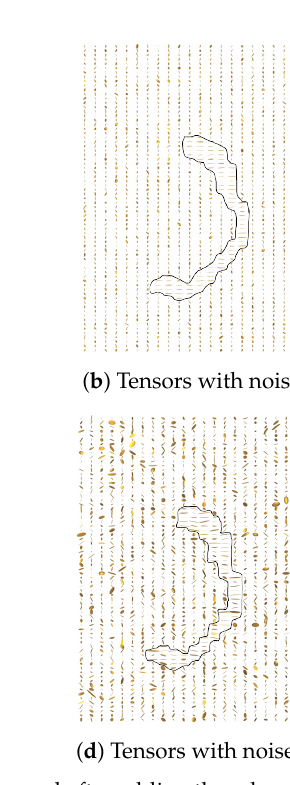
Figure 4. Original and noisy tensors before and after adding three levels of noise.